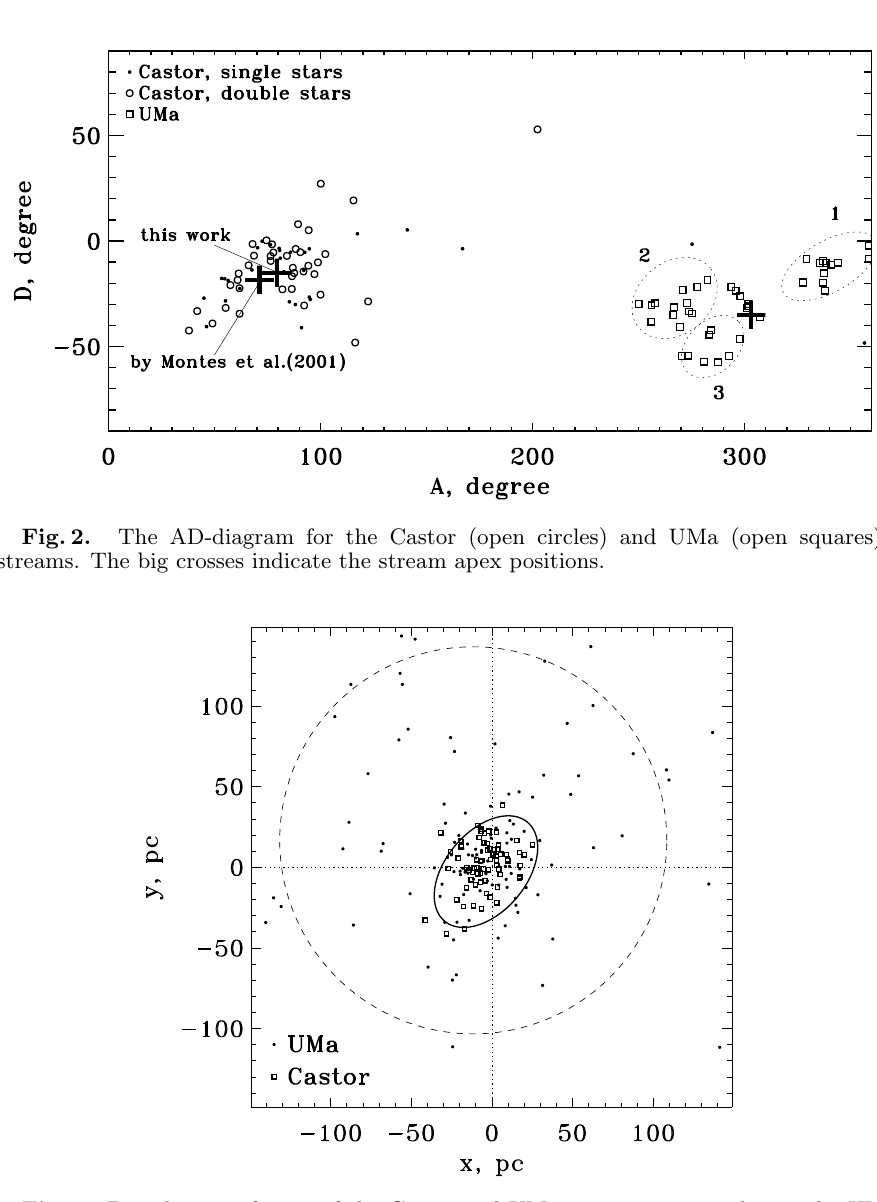
Fig. 3. Distribution of stars of the Castor and UMa streams projected onto the XY plane (Galactic plane). The Castor and UMa stream stars are shown as squares and solid dots, respectively. The areas occupied by the UMa and Castor’s streams are outlined by the dashed and solid lines,